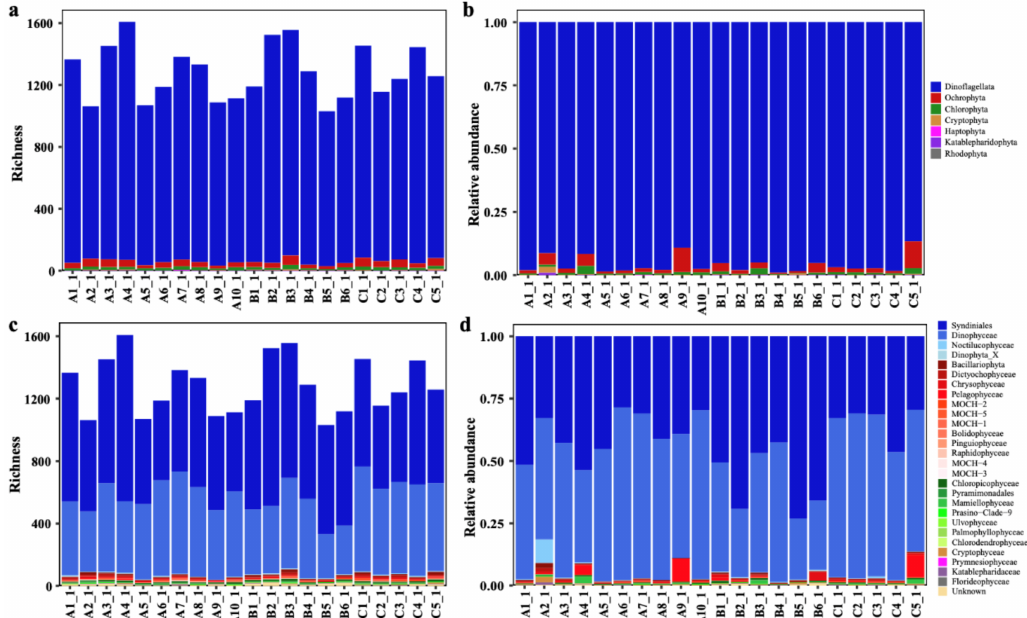
Figure 5. Phytoplankton richness and relative abundance at each surface sampling site in the Western Pacific seamount regions. ( a , b ) Richness and relative abundance of phytoplankton at the division level, respectively; ( c , d ) richness and relative abundance of phytoplankton at the class